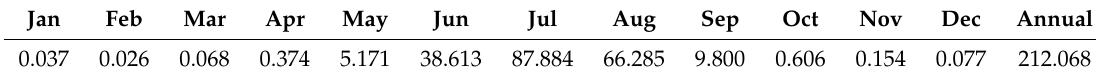
Figure 5. Monthly sediment load at Besham Qila with sediment rating curves (SRC). Table 3. Average monthly load in Mt at Besham Qila with